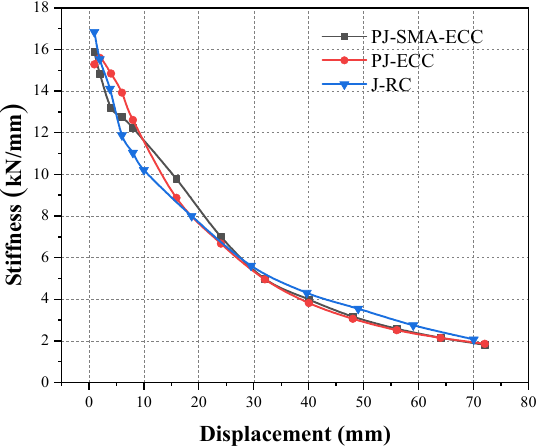
Figure 12. Stiffness degradation.